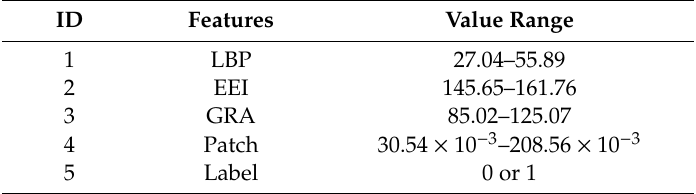
Table 4. Value ranges of the dental Table 5. Value ranges of the dental dataset.